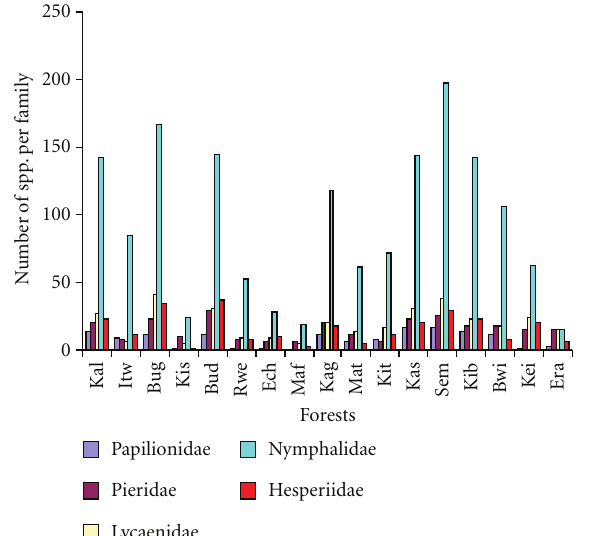
Figure 2: Number of butterfly species per family in the 17 West Albertine Rift Forests.Era: Era; Kei: Mt. Kei; Bwi: Bwindi; Kib: Kibale;Sem: Semliki; Kas: Kasyoha-Kitomi ; Kit: Kitechura; Mat: Matiri;Kag: Kagombe; Maf: Mafuga;Ech: Echuya; Rwe: Rwenzori ; Bud: Budongo; Kis: Kisangi;Bug: Bugoma; Itw: Itwara;Kal: Kalinzu-